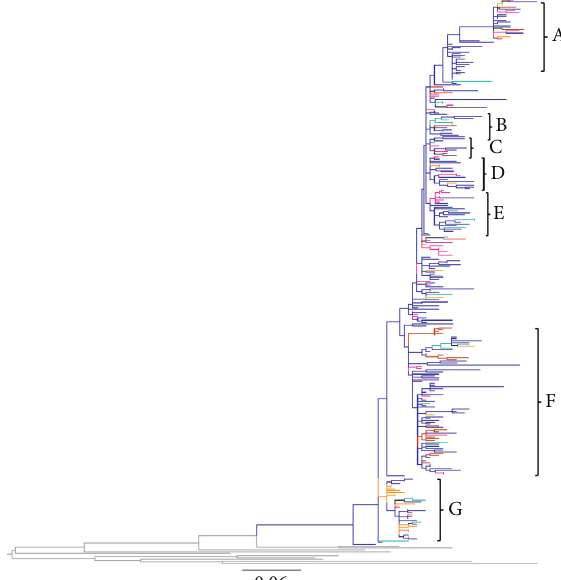
Figure 2: Phylogenetic relationship of HCV genotype 3a NS5B sequences from FSU countries: For the construction of the phy- logenetic tree, a stretch of HCV sequence corresponding to H77 nucleotide 8322–8555 was used. The sequences are included from Azerbaijan, Georgia, Estonia, Lithuania, Russia, Tajikistan, and Uzbekistan. The color key is the same as for Figure